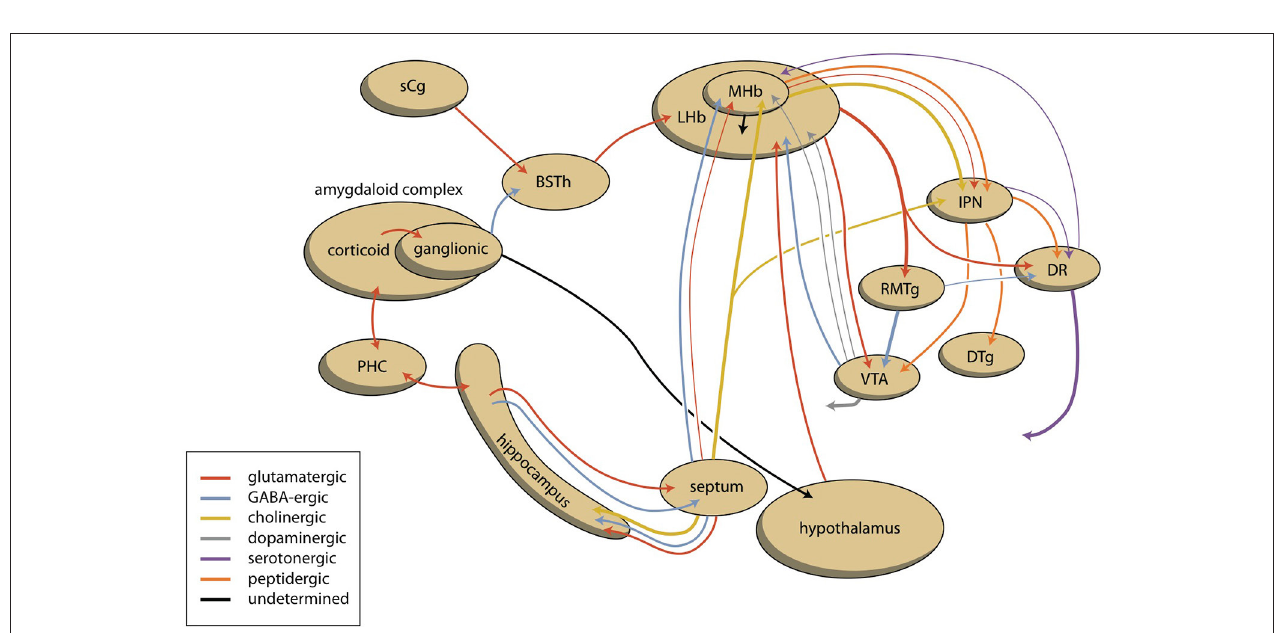
FIGURE 4 | Scheme showing the connectivity of limbic (cortical) system to the midbrain through the habenular complex. BSTh, habenula-projecting part of bed nucleus of the stria terminalis; DR, dorsal raphe nucleus; DTg, dorsal tegmental nucleus; IPN, interpeduncular nucleus; LHb, lateral habenula; MHb, medial habenula; PHC, parahippocampal cortex; RMTg, rostromedial tegmental nucleus; sCg, subgenual cingulate gyrus; VTA, ventral tegmental area (for details see Supplementary